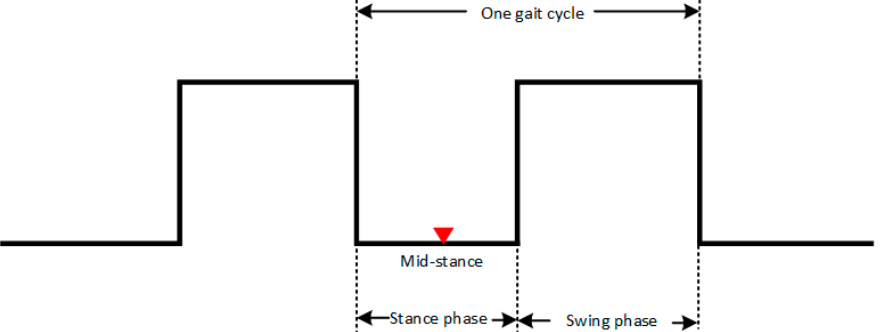
Figure 11 . Sketch map of one gait cycle. It contains stance phase and swing phase. Paper [25] only shows how to detect mid-stance. We expend mid-stance to stance phase using stance phase duration information.